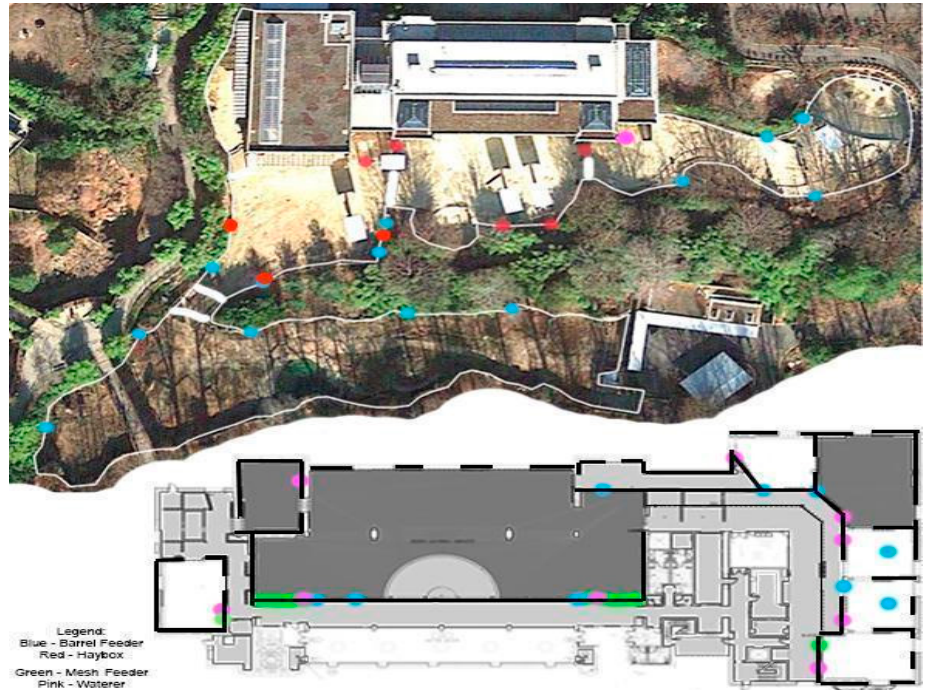
Figure 2. Habitat map created for ZooMonitor to specify elephant locations on 2-min intervals during behavior observations performed on 1.6 Asian elephants at the Smithsonian National Zoological Park. Colored dots represent various habitat features.